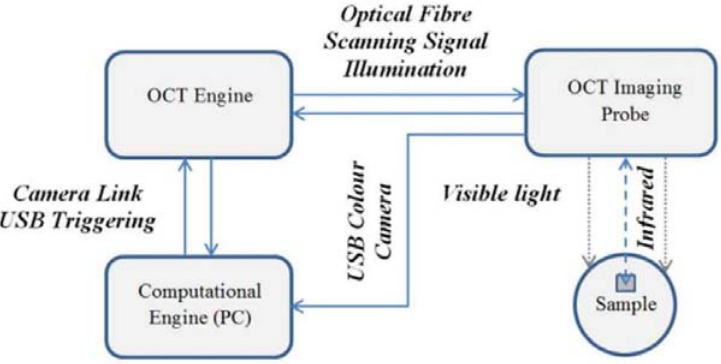
Figure 7. Block diagram of the Spark OCT 1300 nm system.